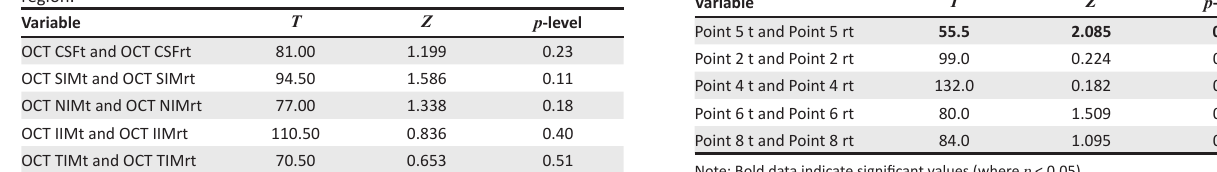
TABLE 6: The Wilcoxon matched pair hypothesis tests comparing test and retest measurements for oscillatory thresholds at Points 2, 4, 5, 6 and 8.